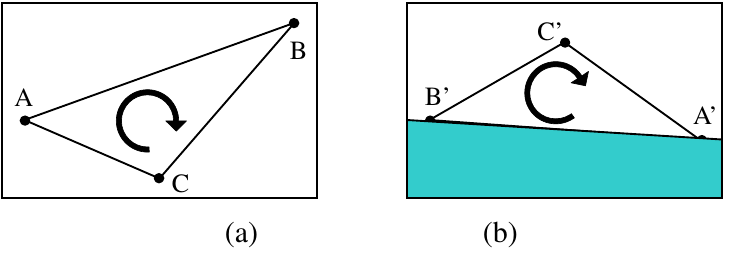
Figure 4. Geometric constraint that must be met by samples when features come from a planar structure. (a) Points A, B and C in a keyframe. (b) Corresponding points A ′ ,B ′ and C ′ in input frame. Point C ′ must not be located in shaded region, since A ′ , B ′ , C ′ must have the same relative order than A, B,